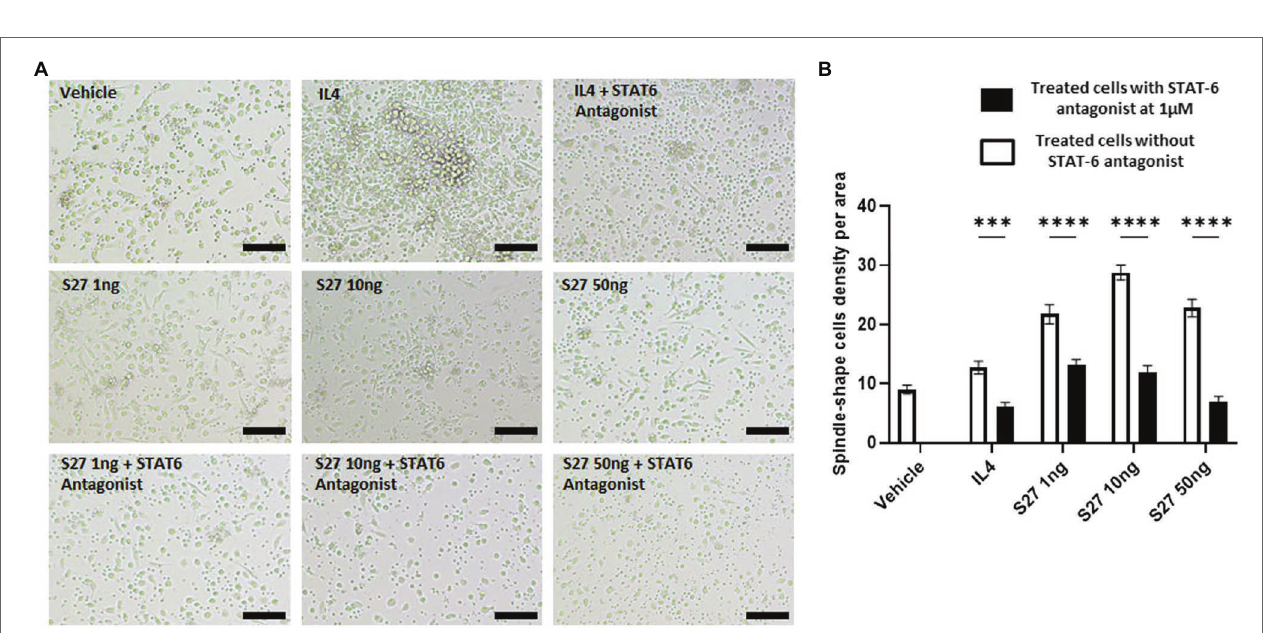
FIGURE 9 | Morphological changes of macrophages in response to different treatments. (A) microscopy-based detection of treated macrophages. Cells were treated with different concentrations of S27 (1, 10, and 50 ng/ml), S27 mixed with STAT-6 antagonist. Untreated cells and IL-4 were used as negative and positive controls, respectively. Scale bar = 50 um, magnification 10×, Olympus microscope. (B) Counts of macrophages with spindle shape, represented as count per area for more than three fields. White bars representing vehicle, S27 1, 10 and 50 ng. Black bars represent same treatments with the presence of STAT-6 antagonist. The results were analyzed using two-way ANOVA and presented as means ± SEM of three independent experiments. *** p < 0.001 and **** p < 0.0001, which is significantly different from the other